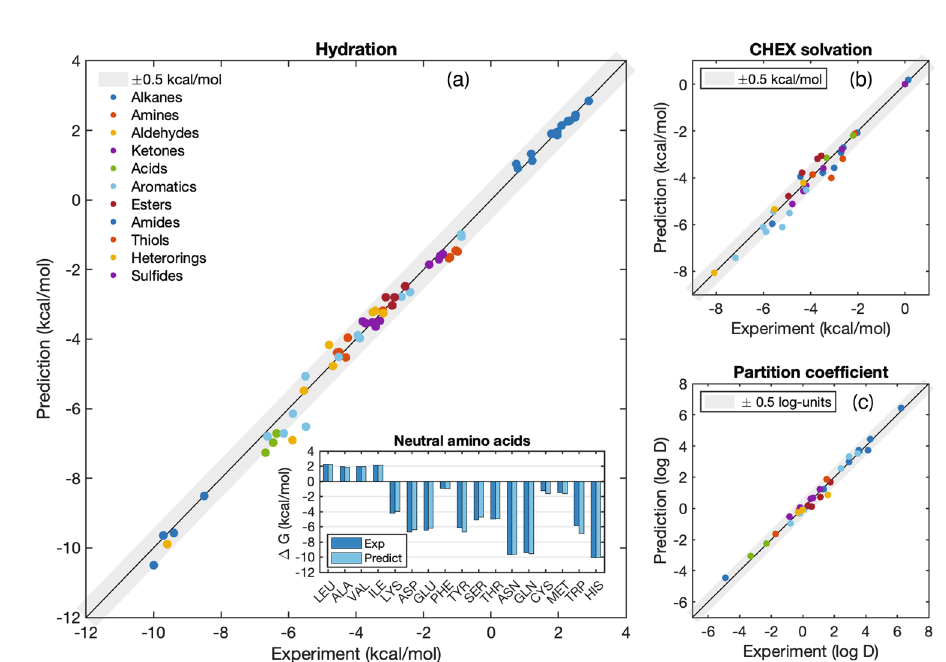
Fig. 3 ARROW force fi eld solvation predictions. a Predicted vs. experimental free energy of hydration for a diverse set of compounds. The straight line is a line of perfect agreement between experimental and theoretical values, and the gray bar is the range of chemical accuracy. The predicted and experimental free energies of hydration for neutral amino acid analogs are inset. b Predicted vs. experimental free energy of solvation in cyclohexane. The molecules here are a subset of those in a because only those with experimental values for CHEX solvation can be included. c H 2 O/CHEX partition coef fi cient for the same set as b . The free energy predictions are well within chemical